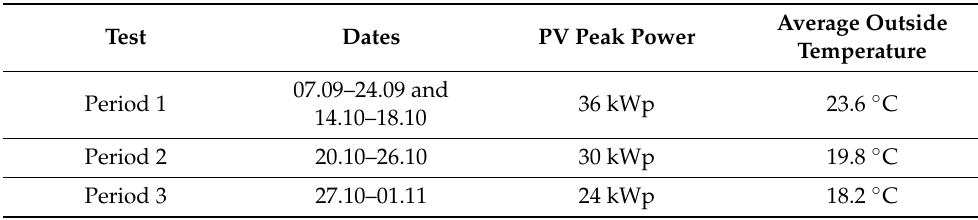
Table 2. Testing